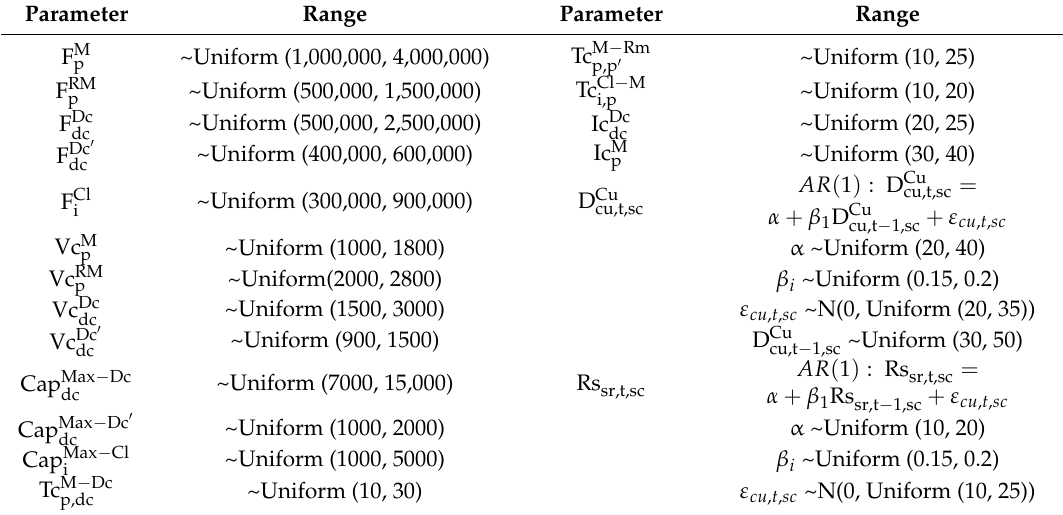
Table 3. Nominal values of the model parameters. For most of the parameters, a uniform distribution is utilized. For demand and return, an autoregressive time series (AR) is